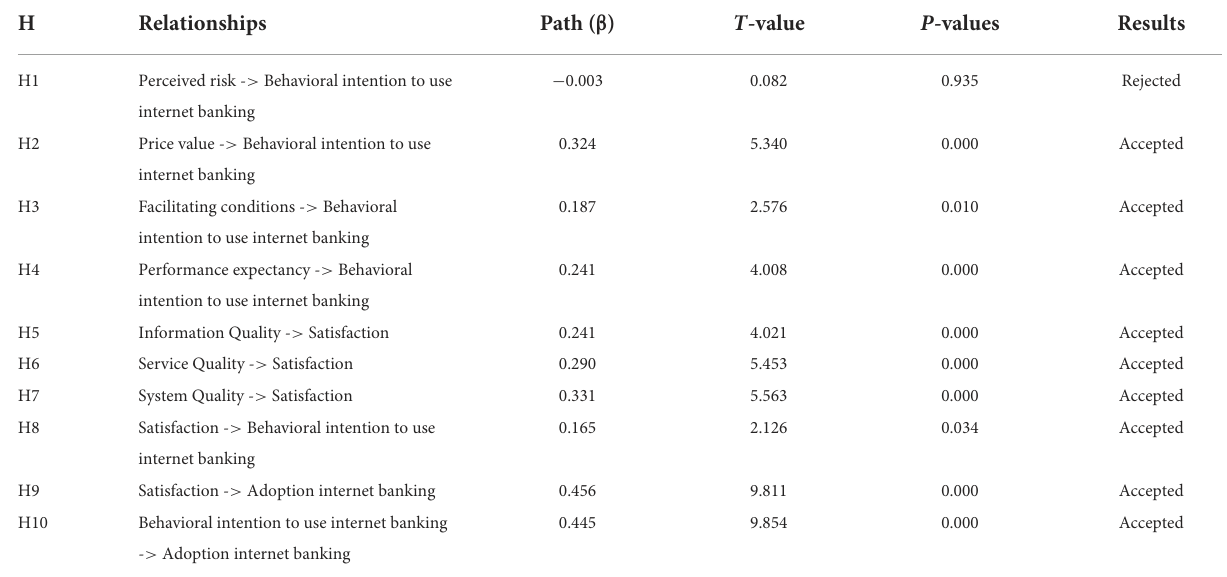
TABLE 5 Relationships for